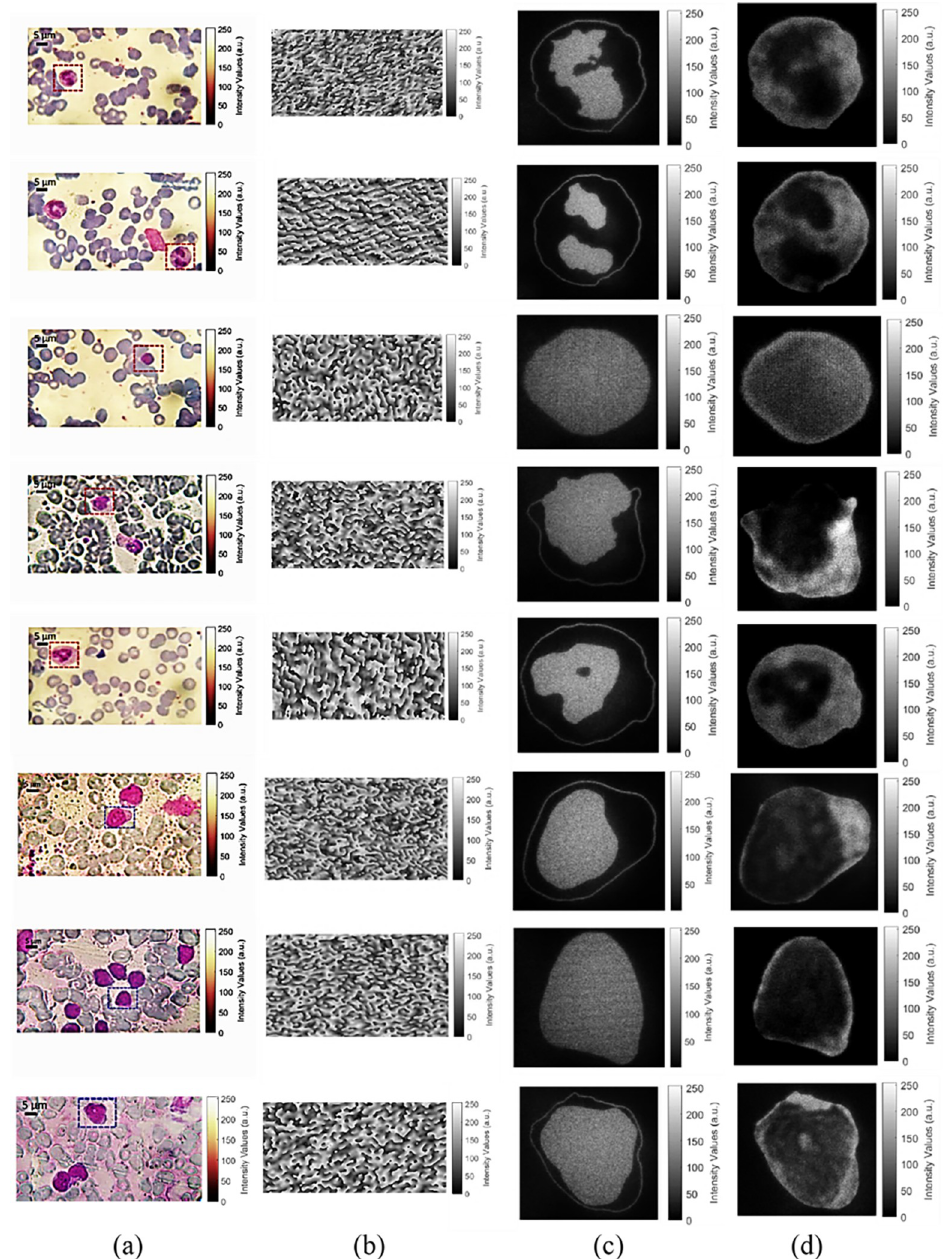
Fig 11. (a) Microscope colored raw images of normal WBCs (marked with red dashed box) and cancer WBCs (marked with blue dashed boxes). (b) The calculated CGHs of the morphology of the targeted WBCs (in the dashed boxes). (c) The optical reconstruction of the WBCs morphology. (d) The optical reconstruction of the WBCs